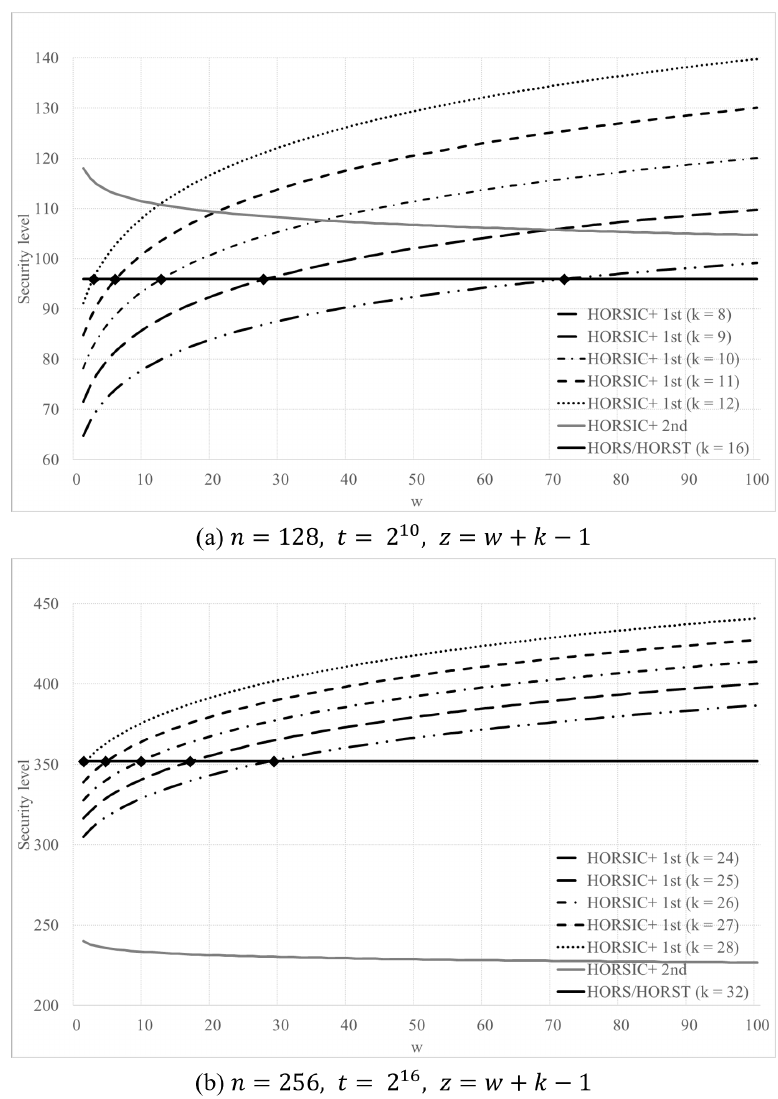
Figure 2. Security level of HORSIC+ for various choices of k and HORS/HORST for signing a single message. The parameters are chosen from ( a ) HORS and ( b ) HORST as used in